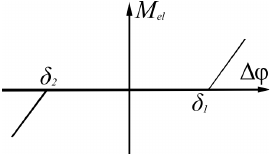
Fig. 5. Gear of mechanical transmission